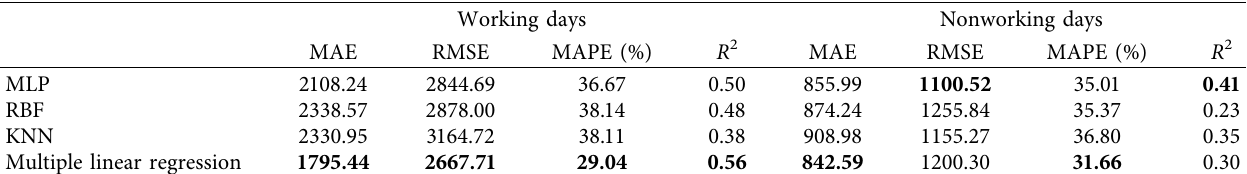
Table 6: Model training accuracy analysis—peak hour passenger